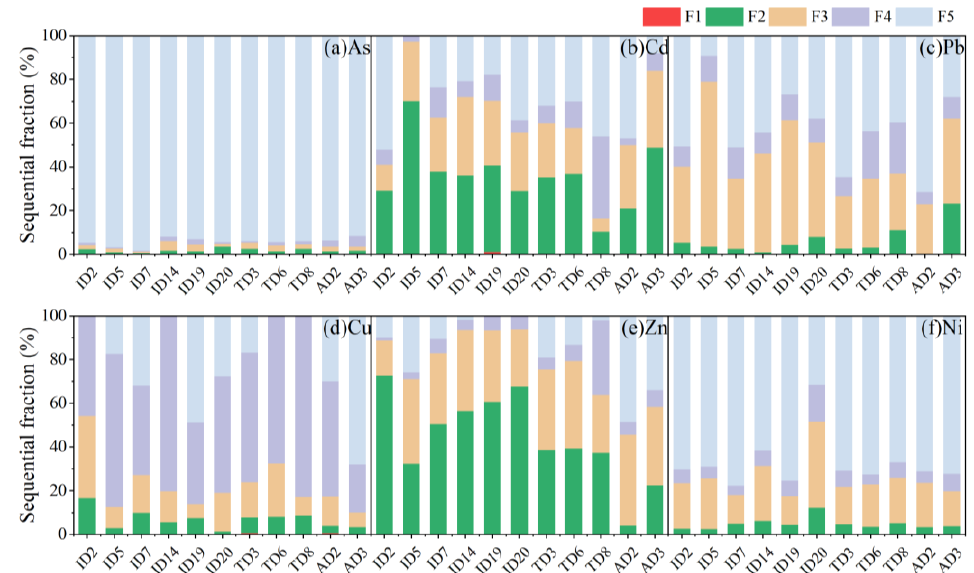
Figure 4. Chemical fractions of trace metals in the road dust from the industrial park area (ID), traffic intersection (TD), and agricultural field (AD) areas of Guangzhou using the sequential extraction procedure: exchangeable fraction (F1), carbonate-bound and specifically adsorbed fraction (acid extractable, F2), Fe/Mn oxide fraction (reducible, F3), organic/sulfide fraction (oxidizable, F4), and a residual fraction (F5). F5 was determined via subtraction from the pseudo-total digested result.